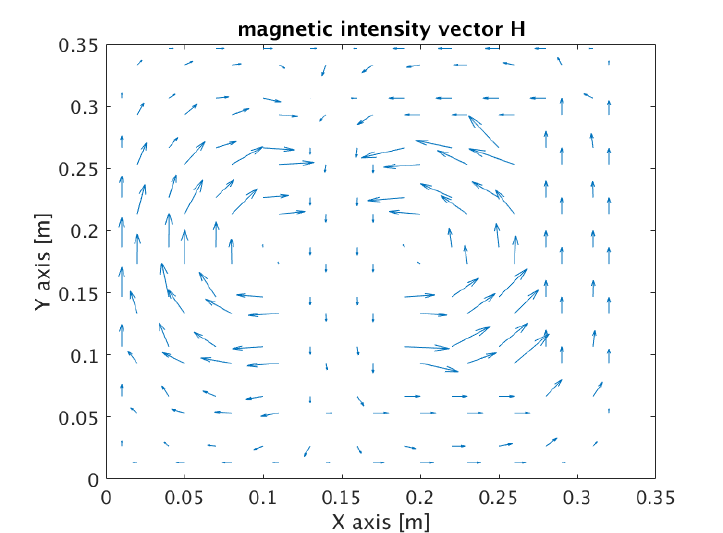
Figure 9. The distribution of the magnetic field intensity vector (cid:126) H corresponding to the magnetic flux density (cid:126) B from Figure 8 ω = 3141.6 rad and time t = 0.1 s. s